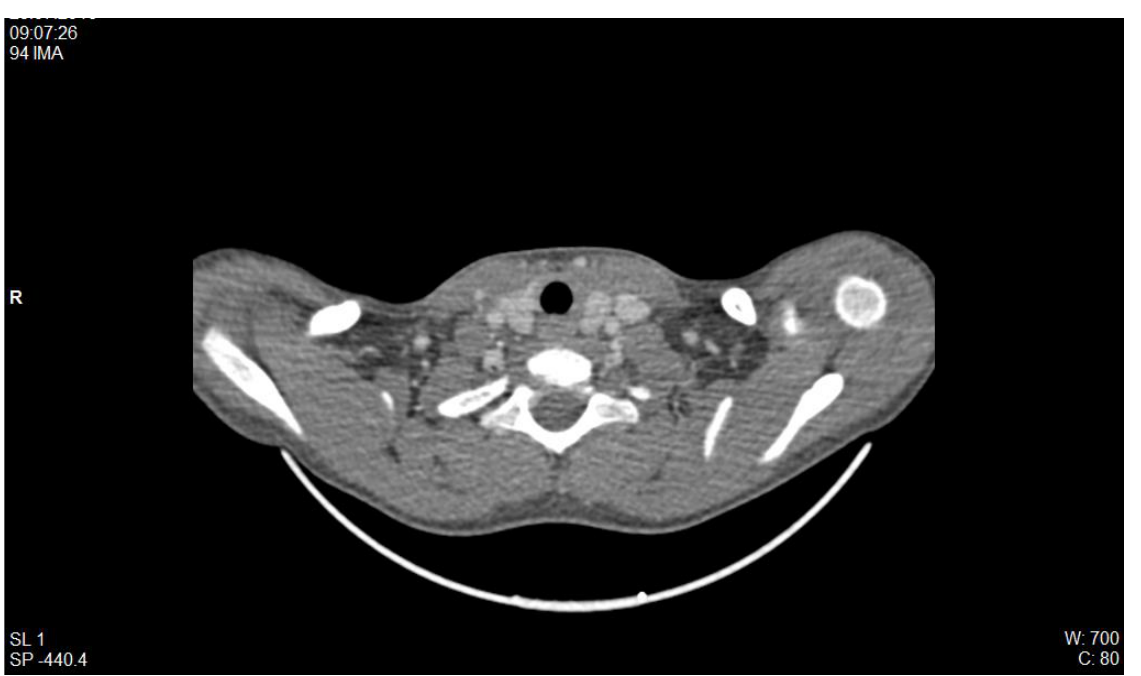
Figure 5. CT scan, evaluation 2 months after the acute episode reveals persistence of thrombosis in the right IJV without progression (personal collection Nephrology